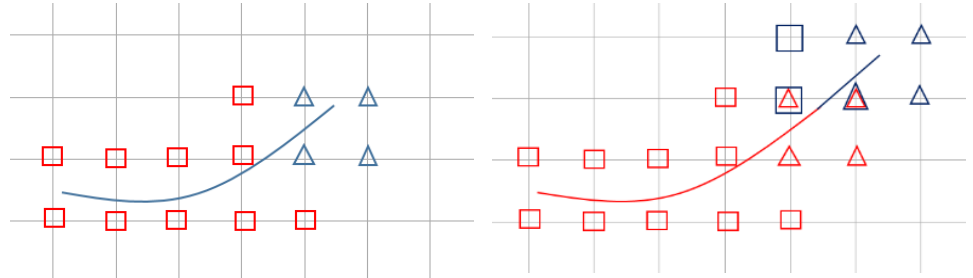
Figure 1. Step of enrichment